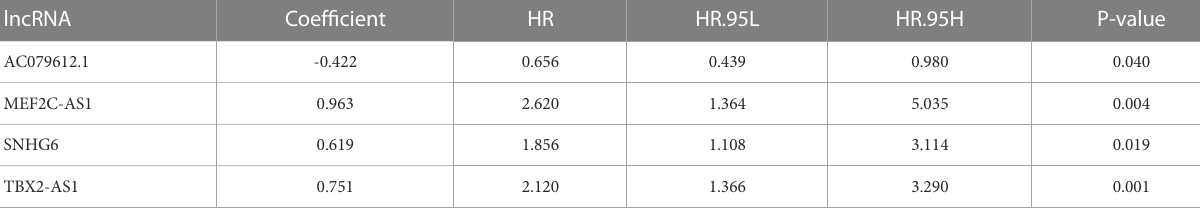
TABLE 2 Optimal prognostic risk signature of four lncRNA by multivariate Cox regression analysis. lncRNA Coef fi cient HR